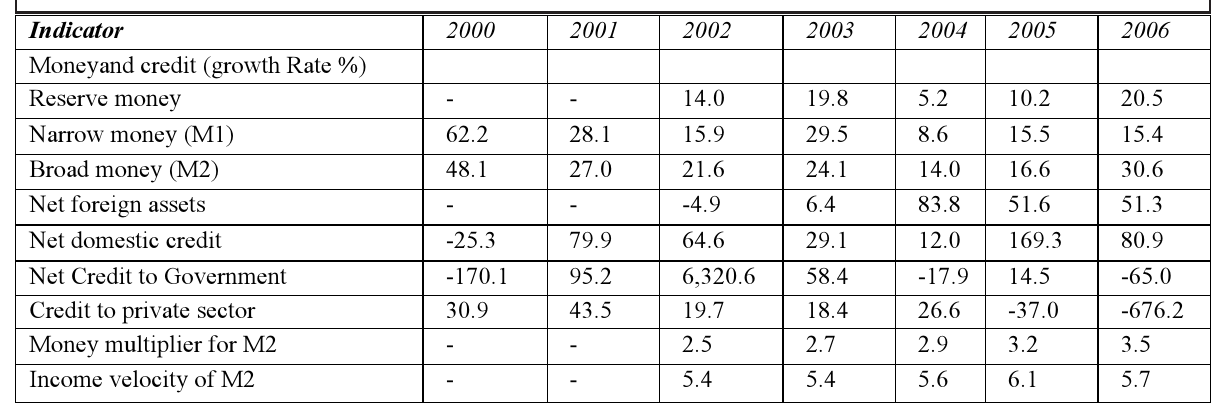
Table 14. Selected Macroeconomic